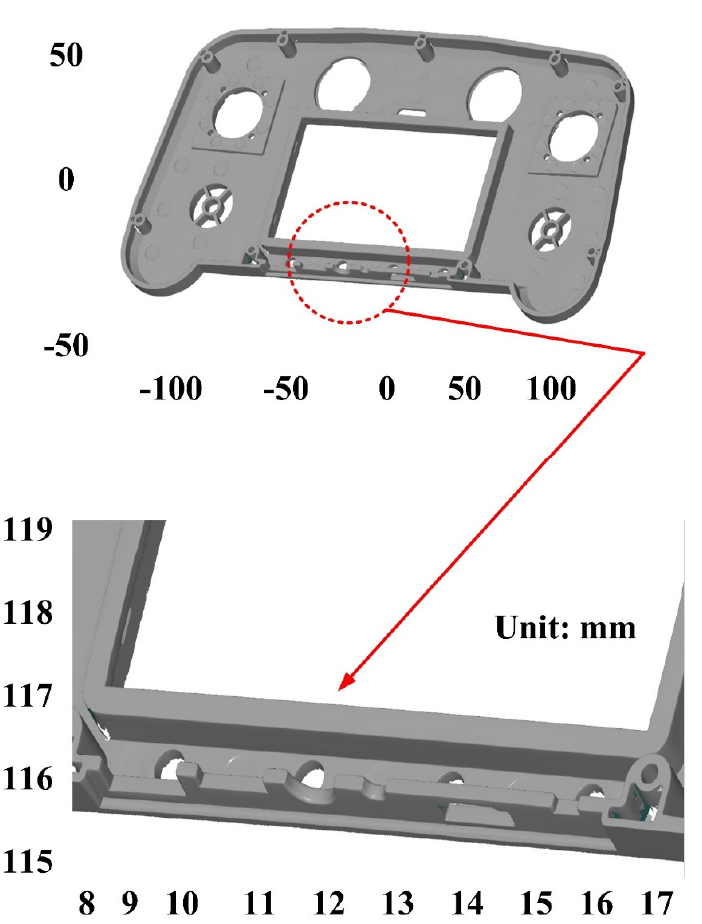
Figure 5. Measurement results of light-colored plastic part sprayed with mixture of TiO 2 powder and ethanol.